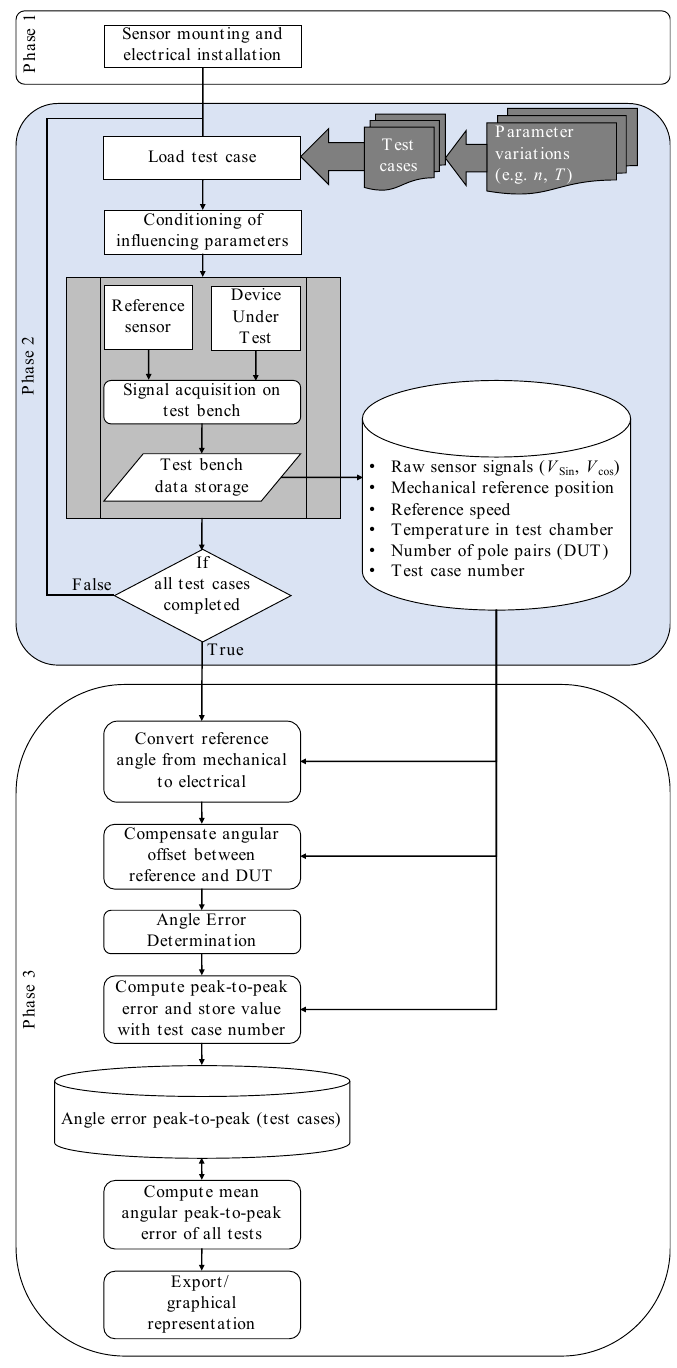
Figure 19. Illustration of the sensor characterization process.